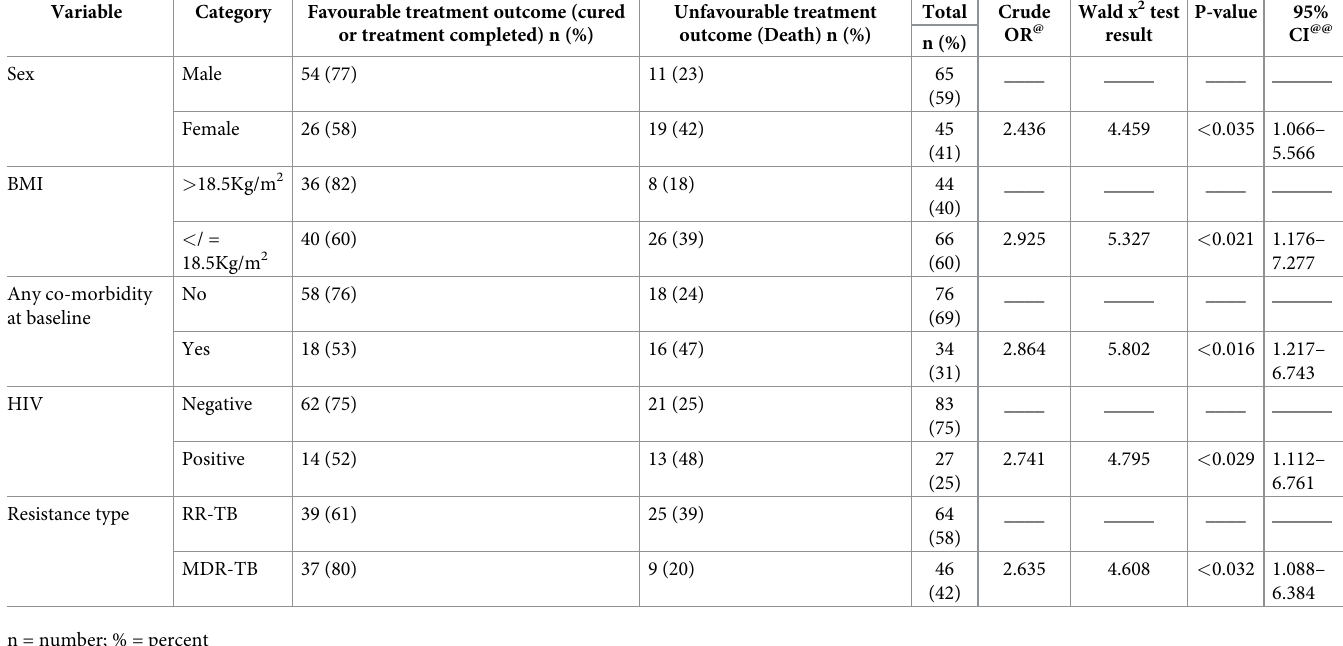
Table 3. Summary of bivariate analysis on the determinants of MDR-TB treatment outcomes of the study participants at Adama and Nekemte Hospitals, Oromia, Ethiopia, December 2012 –September 2016 (n = 110). Variable Category